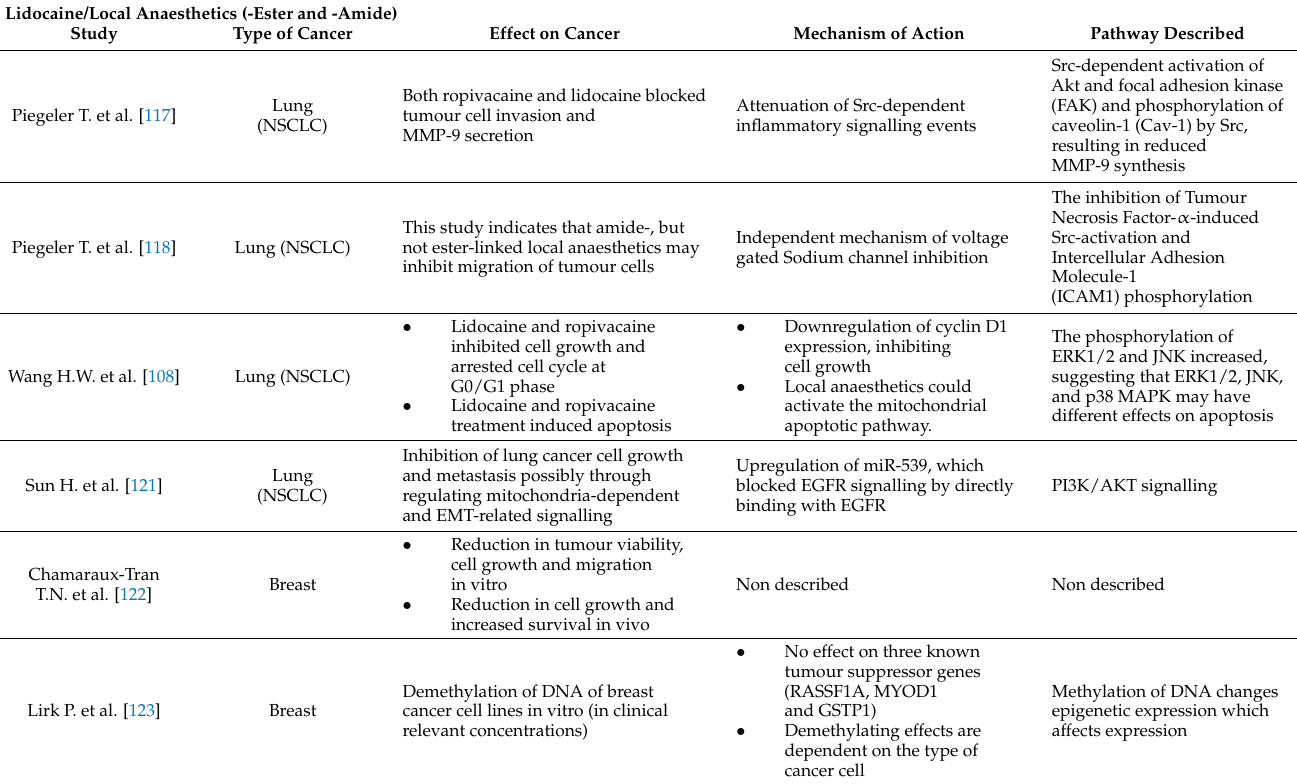
Table 5. Studies describing the direct effects of Lidocaine on cancer cells, the associated mechanisms of action, and their respective pathways 1